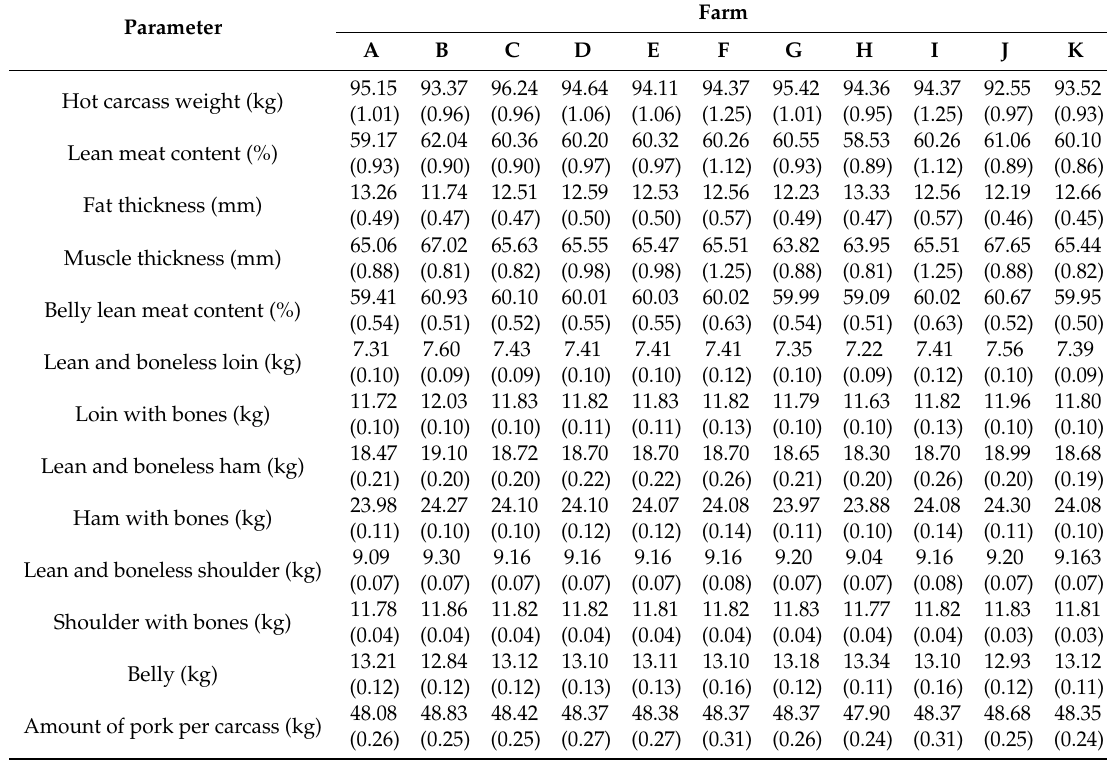
Table 4. Carcass characteristics and estimated primal pork cuts using AutoFOM III data for farms (best linear unbiased estimator (BLUP) ±